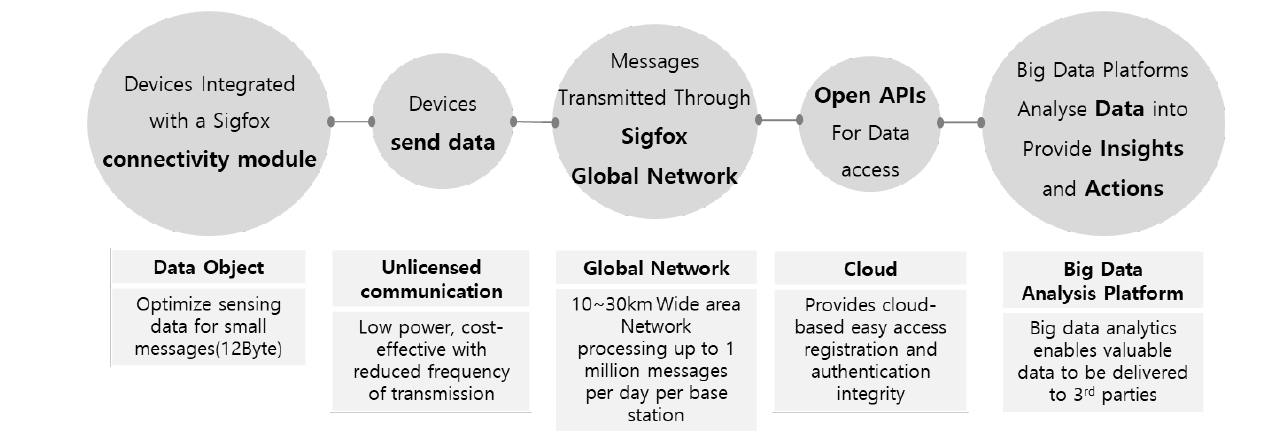
Figure 3. Sigfox Characteristics [4].